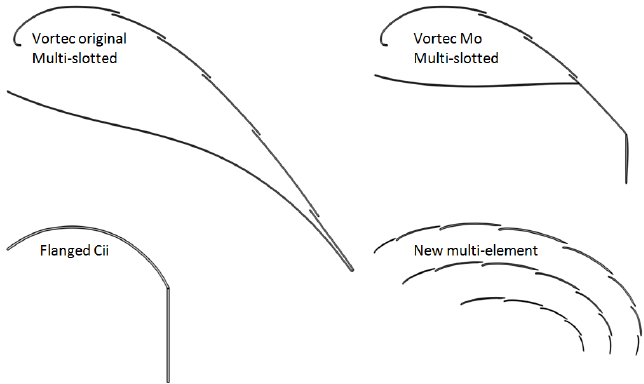
Figure 8. Outline of the 4 high-efficiency diffusers, scaled to fit the same size rotor disk.